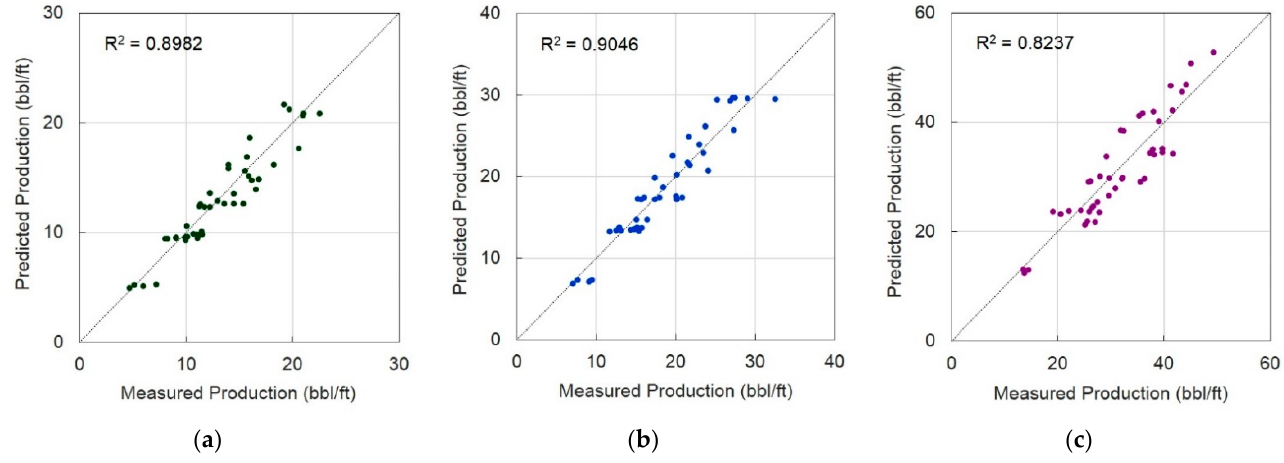
Figure 24. Comparison of the measured and predicted production for the new wells: ( a ) NP 6; ( b ) NP 12; ( c ) NP 24.